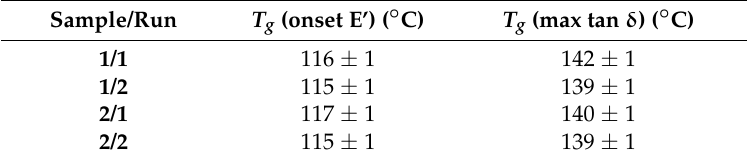
Table 3. T g values for UHM CFRP tendons measured during first and second heating runs of DMTA testing.